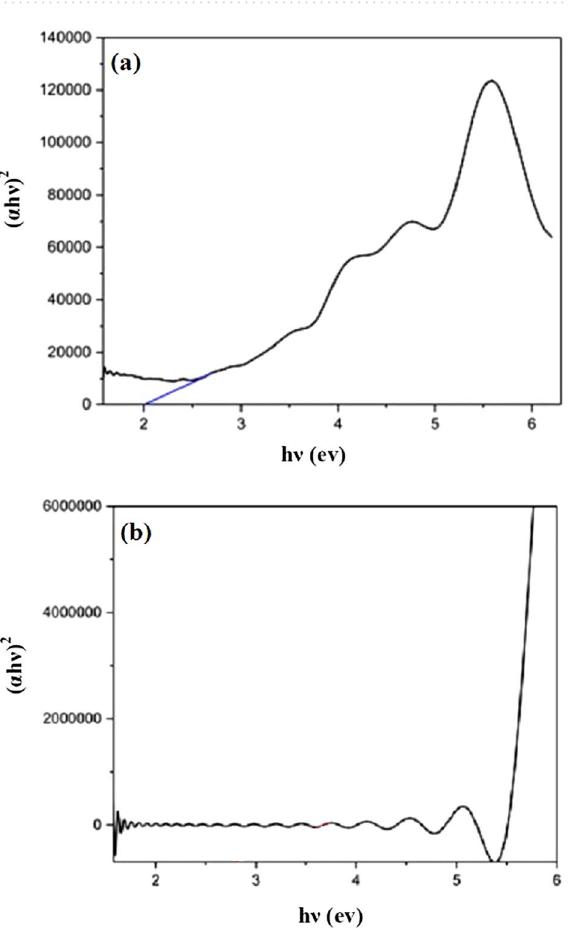
Table 1. The TGA results, including T d and weight loss (%) of CdS@HPEc-g-PANi and mCdS@HPEc-g-PANi nanocomposites.